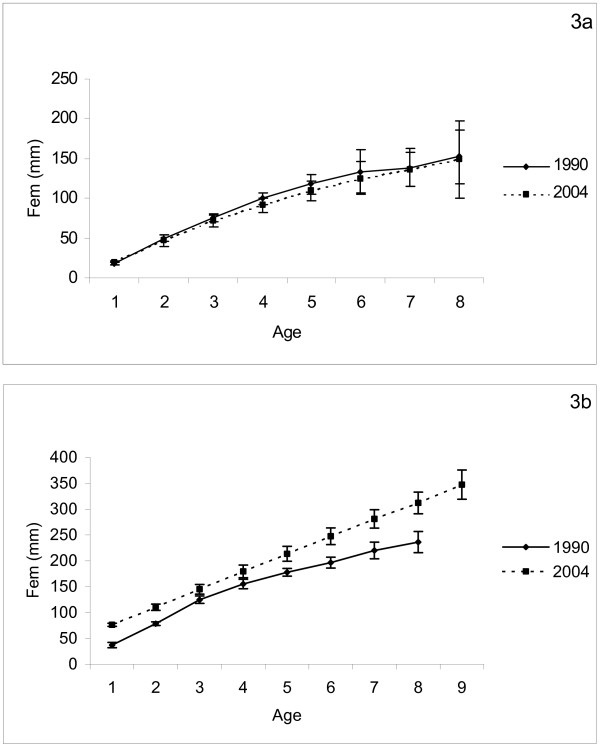
Comparison of growth rates of Arctic charr from Kangarssuk and Røde Elv sampled in 1990 and 2004. (a) Changes in values of fork length estimated means showing growth during life history of fish living at Røde Elv in 1982–1989 and 1995–2003 (Fem = Values of fork length estimated means; error bars: ± 95% C.L; ANOVA: p = 0.008; d.f. = 7) and (b) at Kangarssuk in respectively 1982–1989 and 1995–2003 (Fem = Values of fork length estimated means; Error bars: ± 95% C.L; ANOVA: p = 0.0004; d.f. = 7).